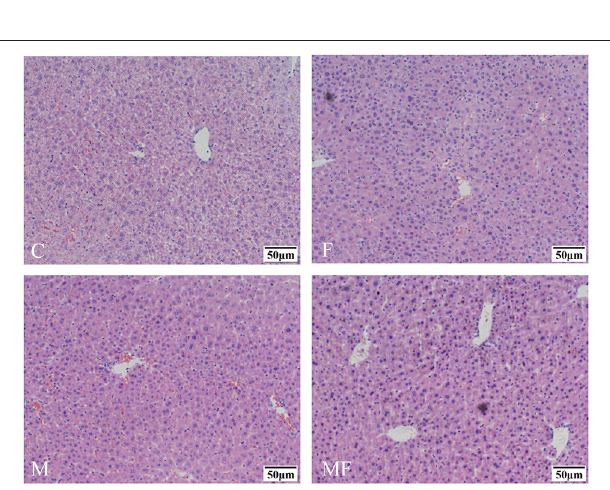
FIGURE 4 | Representative H&E samples showing differences in liver morphology in control mice vs. those with intermittent fasting and/or melatonin treatment. Scale bar: 50 µ m. C, control; F, intermittent fasting; M, melatonin; MF, intermittent fasting plus melatonin. The C and M mice were fed ad libitum , while the F and MF groups underwent alternative-day feed deprivation. The M and MF groups mice were supplemented with melatonin at a dose of 10 mg/kg body weight by drinking.